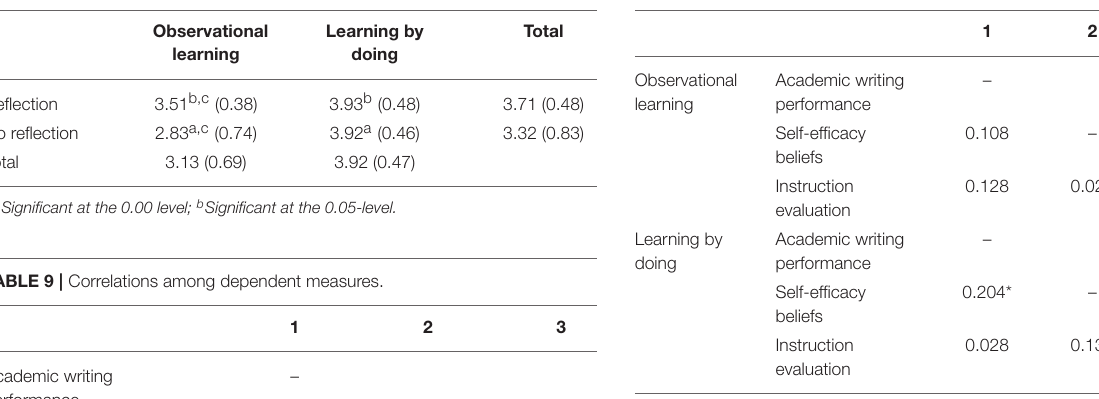
TABLE 10 | Correlations among dependent measures in observational learning and learning by doing conditions.